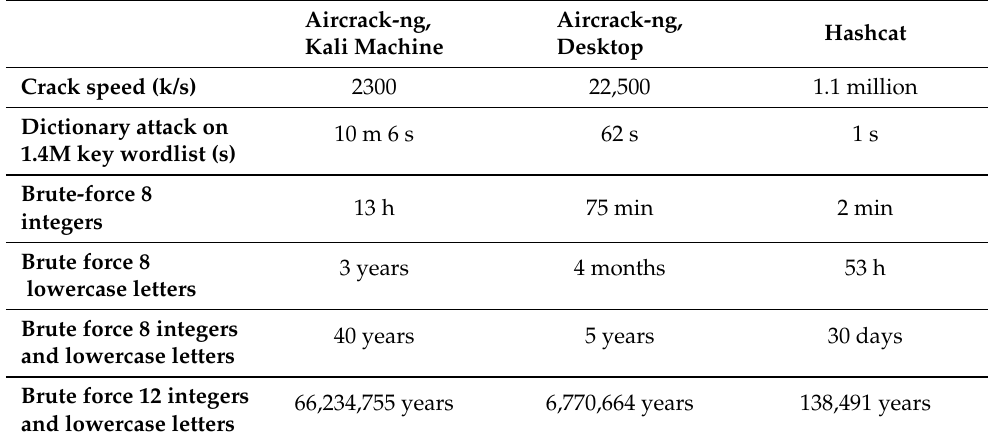
Table 1. Comparison of key test speeds on different wordlists using Aircrack-ng and